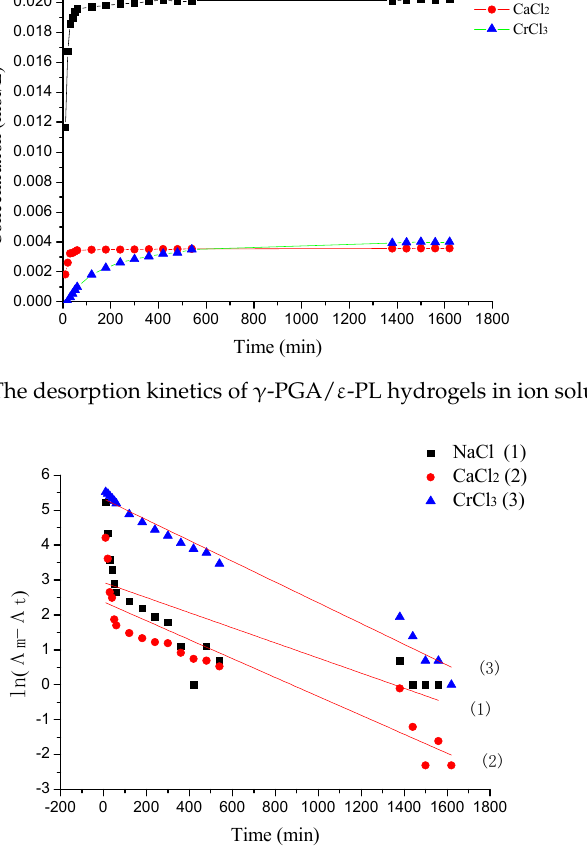
Figure 13. Pseudo-first-order kinetic plot for the desorption of γ -PGA/ ε -PL hydrogels in NaCl, CaCl 2 , and CrCl 3 solutions. Table 4. Constants and correlation coefficients of pseudo-first-order kinetic models for NaCl (1), CaCl 2 (2), and CrCl 3 (3) adsorption onto γ -PGA/ ε -PL hydrogels.